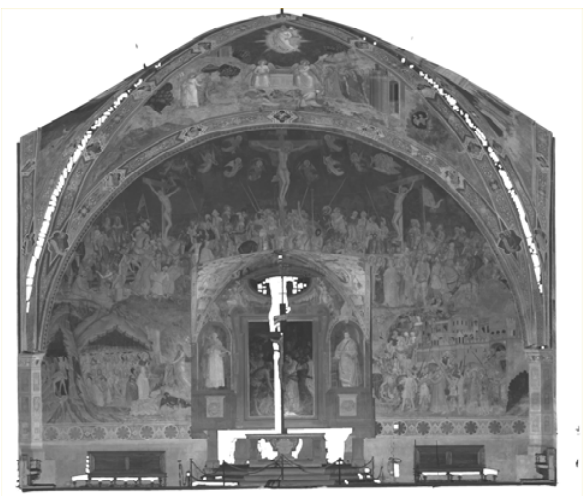
Figure 2. Image of point cloud acquired in grey